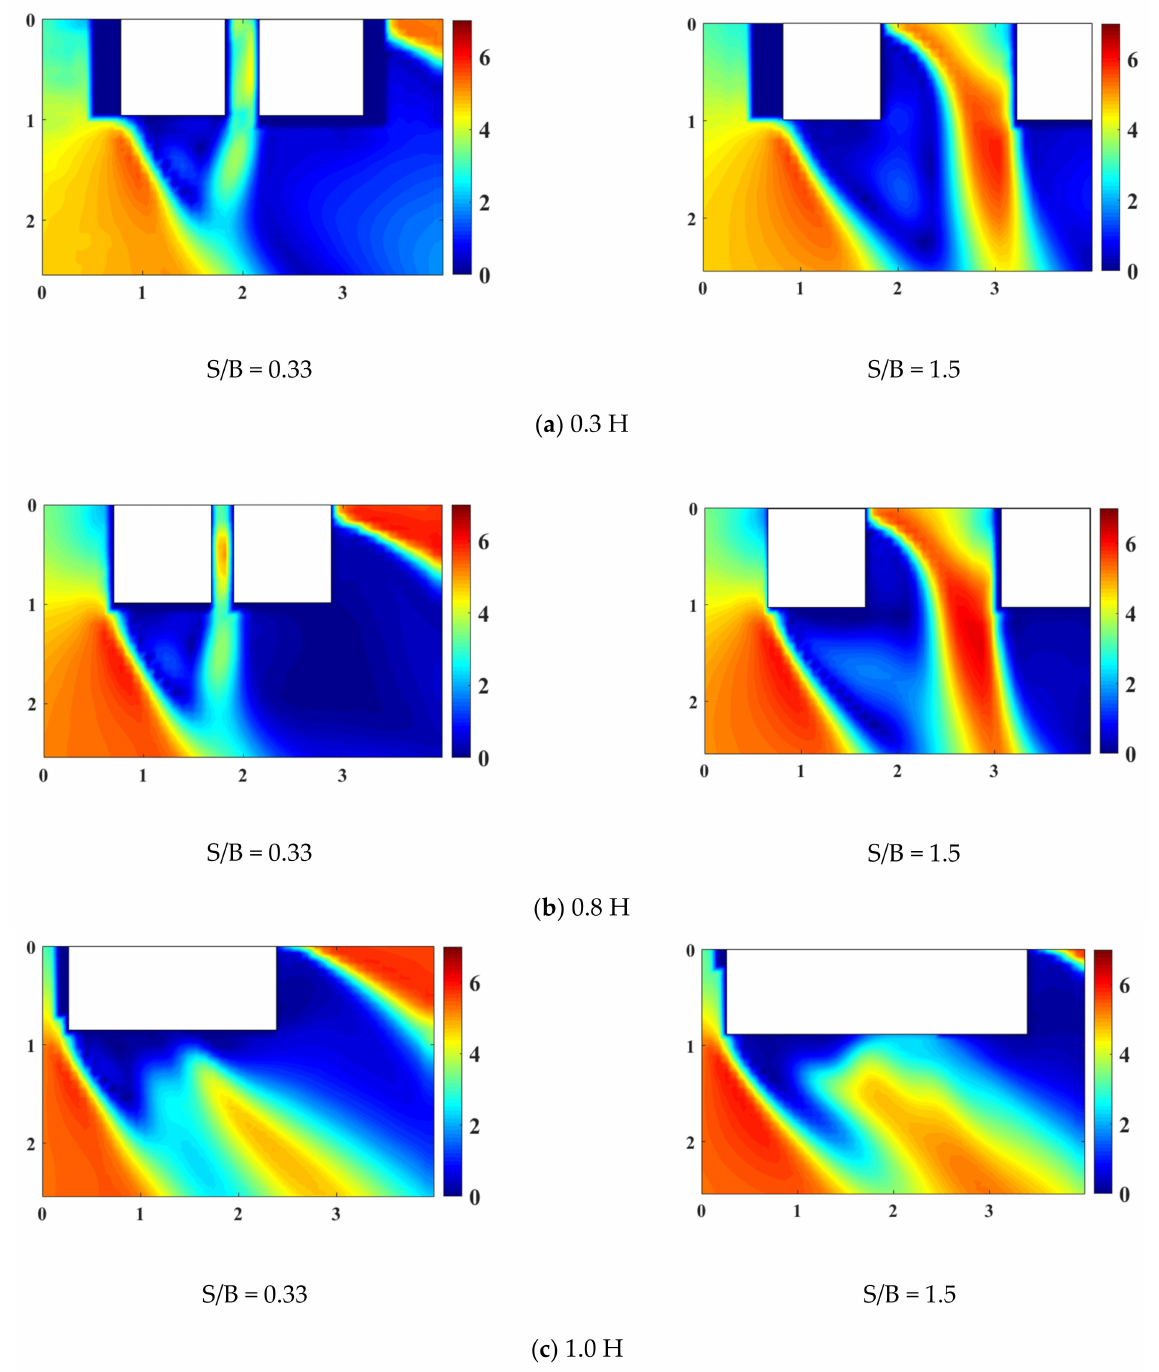
Figure 7. Mean velocity magnitudes around the LB model (unit: